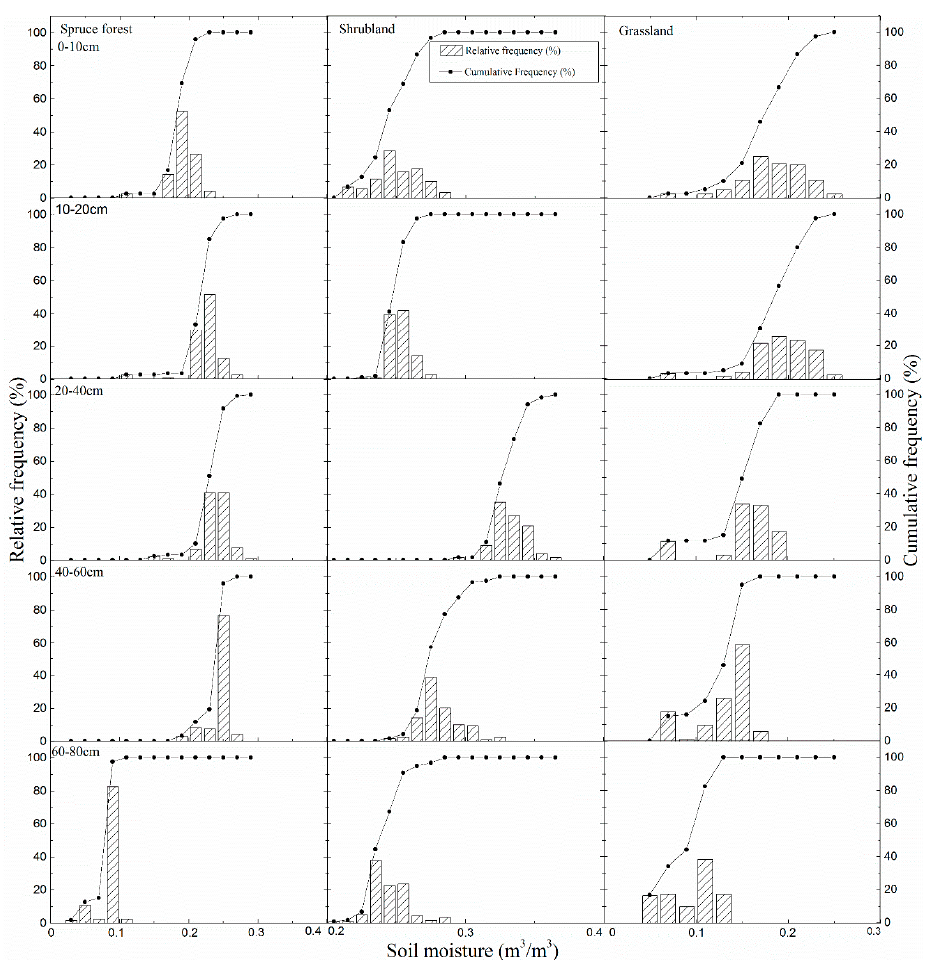
Figure 4. Frequency and cumulative frequency distribution of soil moisture at different soil depths in the three typical types of vegetation during the growing season.